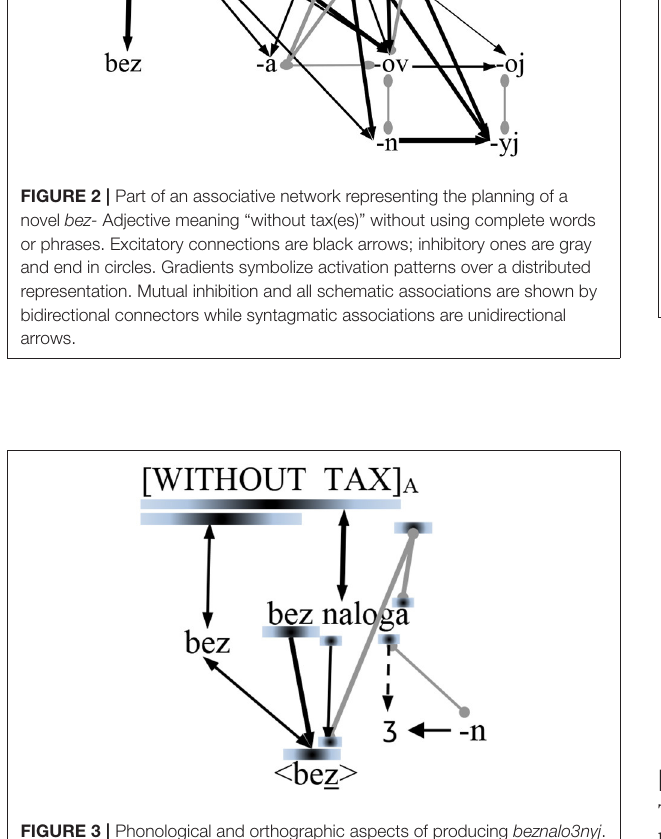
stroit j el j “builder.” However, these adjectives are not derived